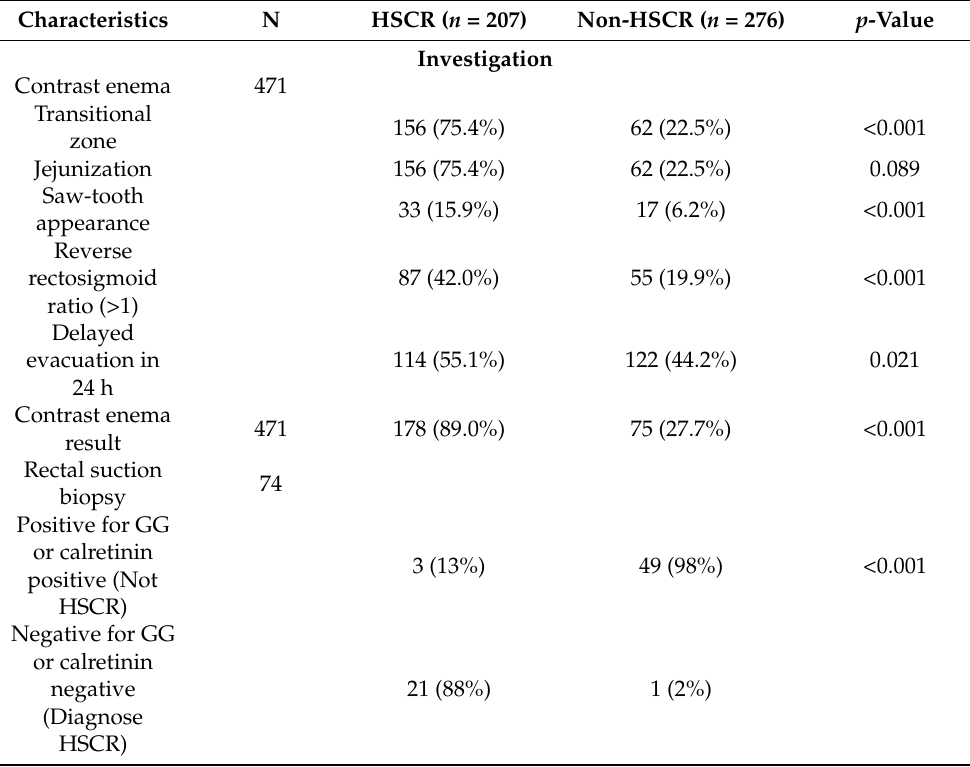
Figure 3. Observed risk (circle) vs. score predicted risk (solid line) of HSCR diagnosis (size of circle represents frequency of HSCR in each score). Table 5. Results of investigation of HSCR and non-HSCR patients in Chiang Mai University Hospital from 2006 to